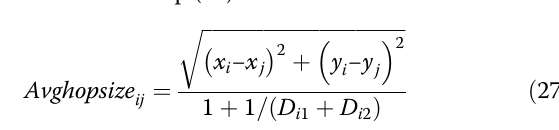
Fig. 5 The relationship between the average positioning error and the proportion of initial beacon